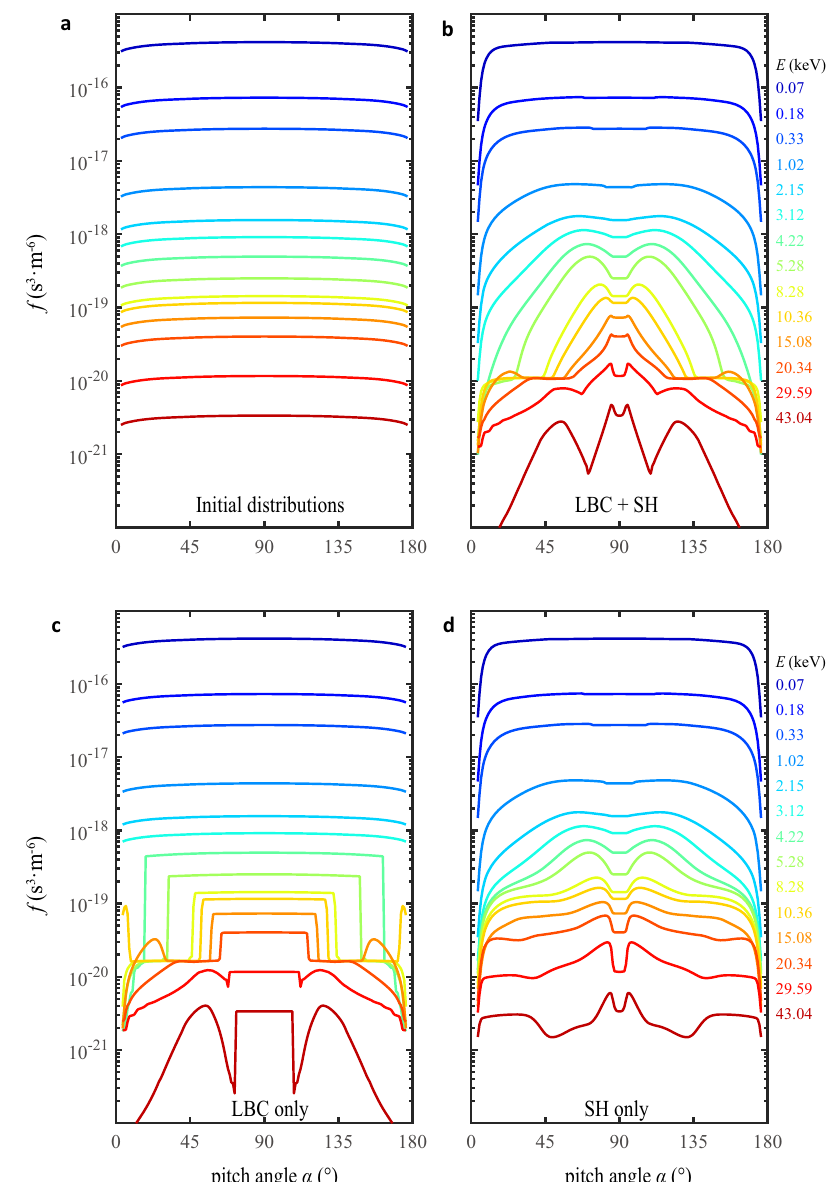
Fig.4|Evolutionofelectronphasespacedistributions.a Initiallyelectronphase space distribution ( f ) is assumed to be rather isotropic, which is correspondingly deformed under2-hour scattering effect of different waves. b Combined diffusion of LBC and SH eventually forms the pancake distribution, after electrons near the